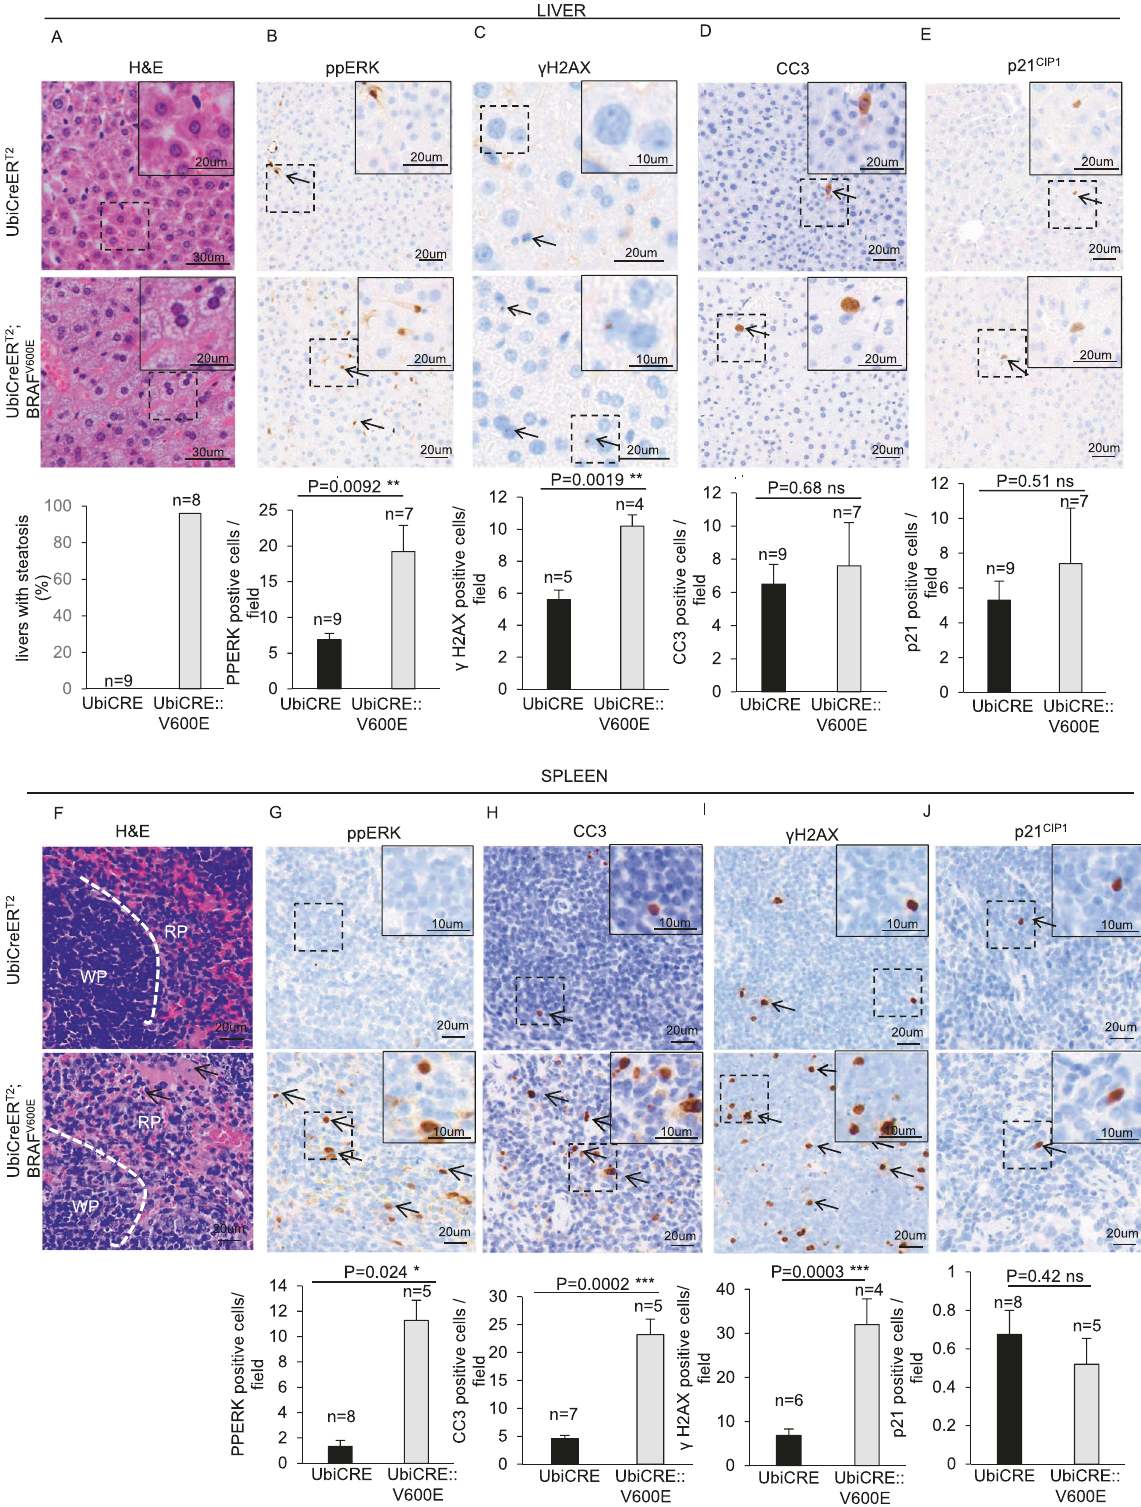
Fig. 1 Early effects of ubiquitous expression of BRAF V600E in liver and spleen. A – E Representative images and quanti fi cations showing A H&E staining, B ppERK, C γ H2AX, D CC3 and E p21 CIP1 immunostainings in liver sections from BRAF V600E and control mice. F – J Representative images and quanti fi cations showing F H&E staining, G PPERK, H CC3, I γ H2AX and J p21 CIP1 immunostainings in spleen sections from BRAF V600E and control mice. Quanti fi cations were performed on fi ve different areas of the sections in a random way. Data are expressed as mean ± SEM; n = animals per group. * P < 0.05; ** P < 0.01; *** P < 0.001, ns = not signi fi cant. (T Student ’ s test unpaired). Arrows point to selected positive cells for the indicated marker. Legend for fi gure F: WP = White Pulp, RD = Red Pulp; the white dashed line marks the boundary between white and red pulps. The arrows point to apoptotic bodies. Insets: magni fi cations of areas inside dashed squares.